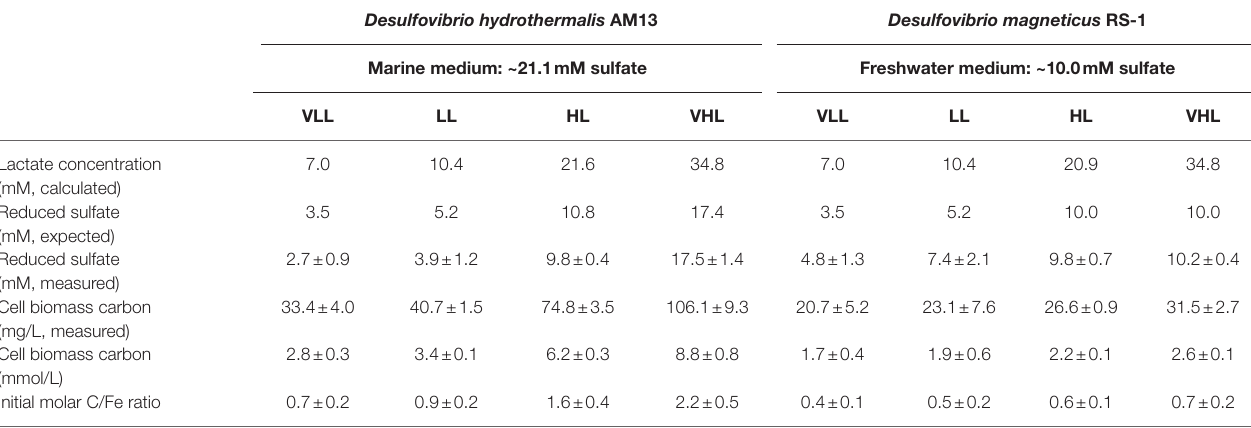
TABLE 1 | Cell biomass production in cultures of the two sulfate-reducing bacteria used in this study: marine strain Desulfovibrio hydrothermalis AM13 and freshwater strain Desulfovibrio magneticus